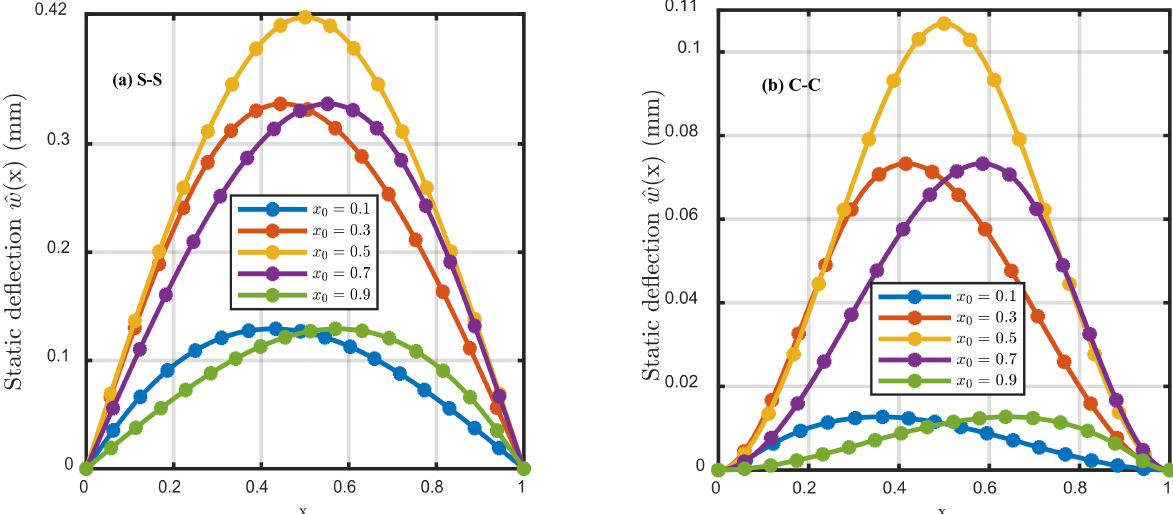
Figure 2. The bending deflection of perfect S–S and C–C composite beams with layup sequence 3H subjected to point load ( L = 100 h , k s = 0, k L = 0, A 0 = 0, ˆ q 0 = 1 N